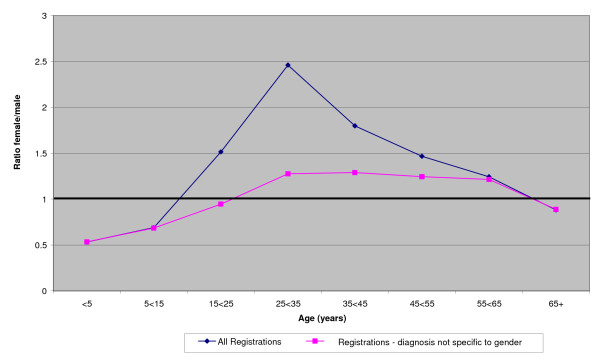
Female/male ratios by age group for registrations in comparisons townships: (ratios corrected for population ratios - see text)